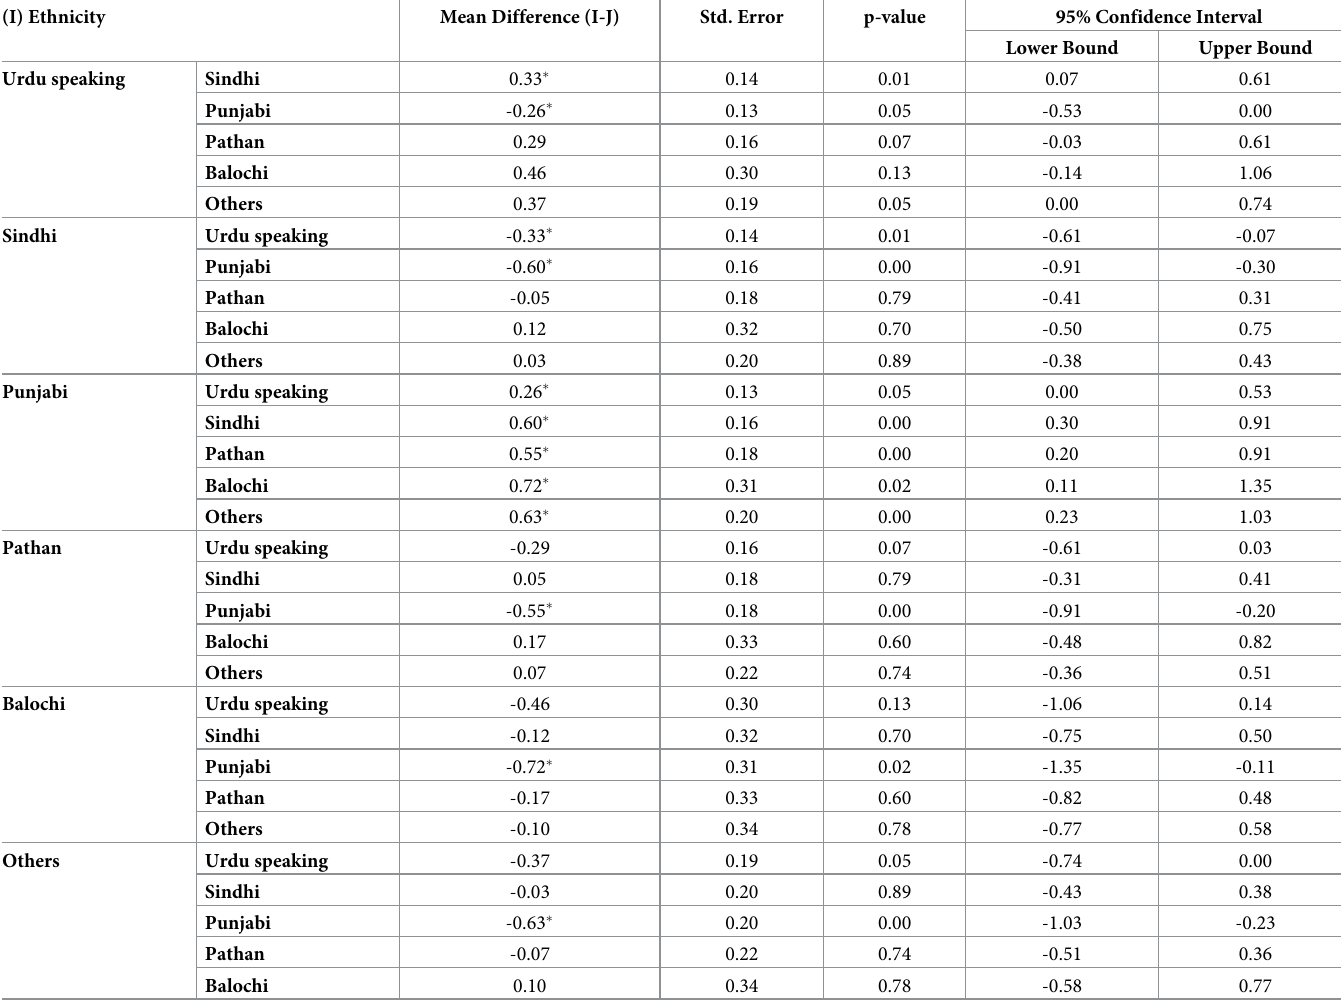
Table 4. Post hoc comparisons using LSD test for mean social influences score and ethnicity. (I)